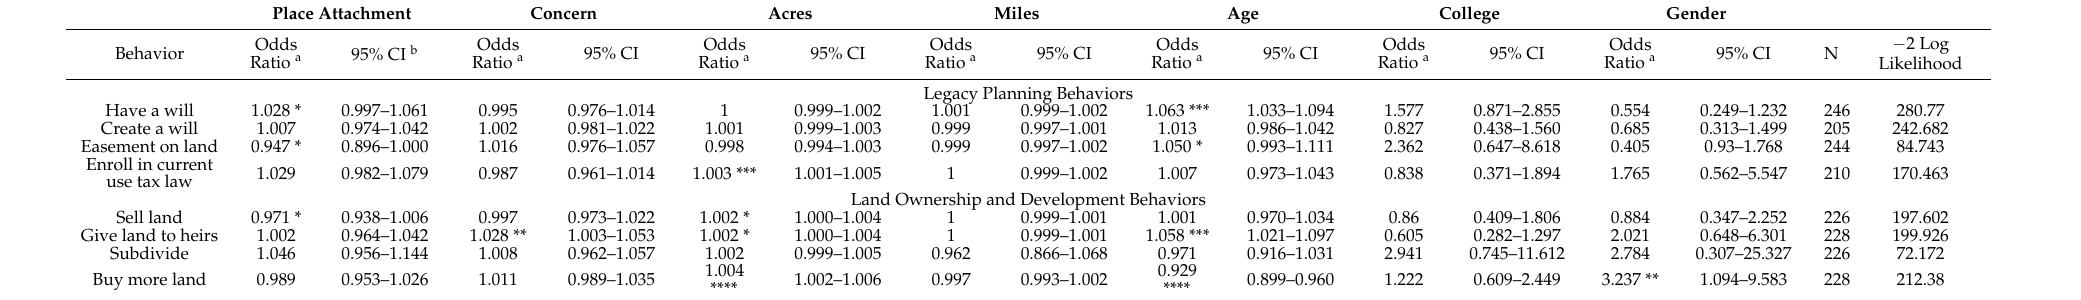
Table 5. Influence of place attachment and landowner concern on behavior/behavioral